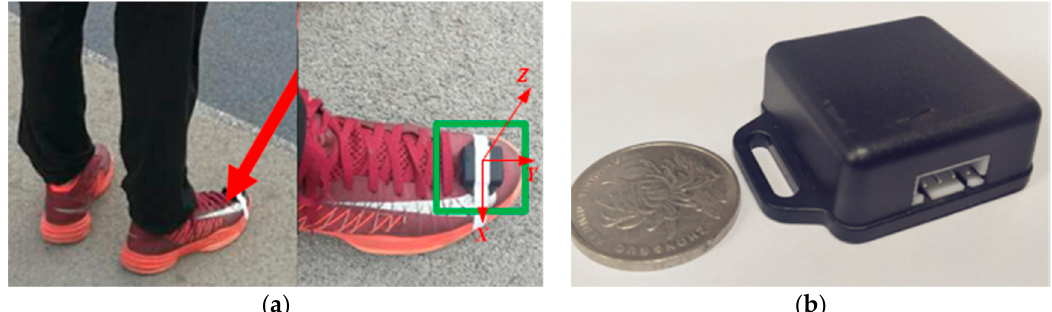
Figure 2. Applied equipment. ( a ) Installation method; ( b ) Exterior. Table 1. Performance parameters for JY-901.